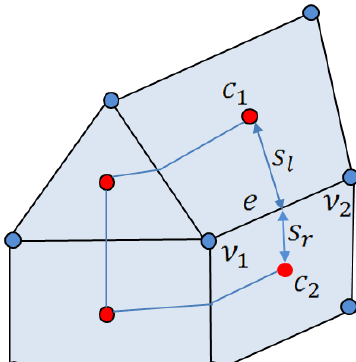
Figure 1. Schematic of mesh structure. Velocities are located at cen- troids (red circles) and elevation at vertices (blue circles). A scalar control volume associated with vertex v 1 is formed by connecting neighboring centroids to edge centers. The control volumes for ve- locity are the triangles and quads themselves. The lines passing through two neighboring centroids (e.g., c 1 and c 2 ) are broken in a general case at edge centers. Their fragments are described by the left and right vectors directed to centroids ( s l and s r for edge e ). Edge e is defined by its two vertices v 1 and v 2 and is considered to be directed to the second vertex. It is also characterized by two elements c 1 and c 2 to the left and to the right,